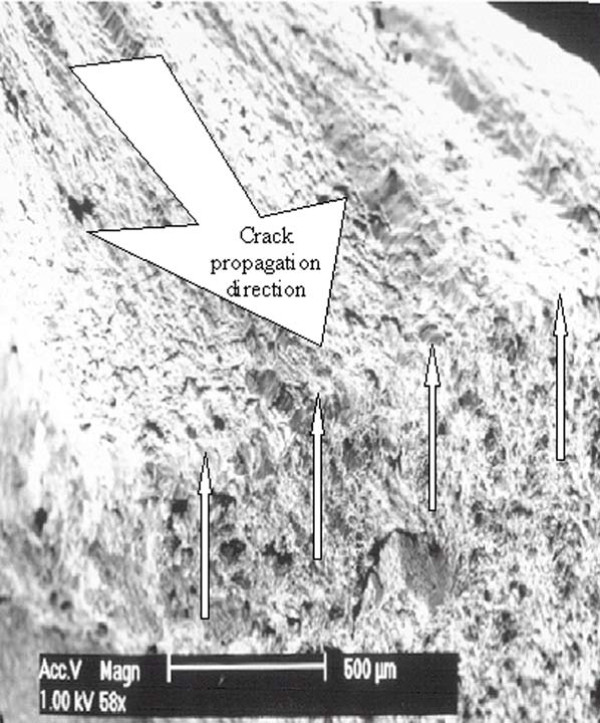
SEM micrograph showing a typical fatigue failure of a stainless steel locking screw. The arrows indicate the crack tip location just prior to final fracture occurred.